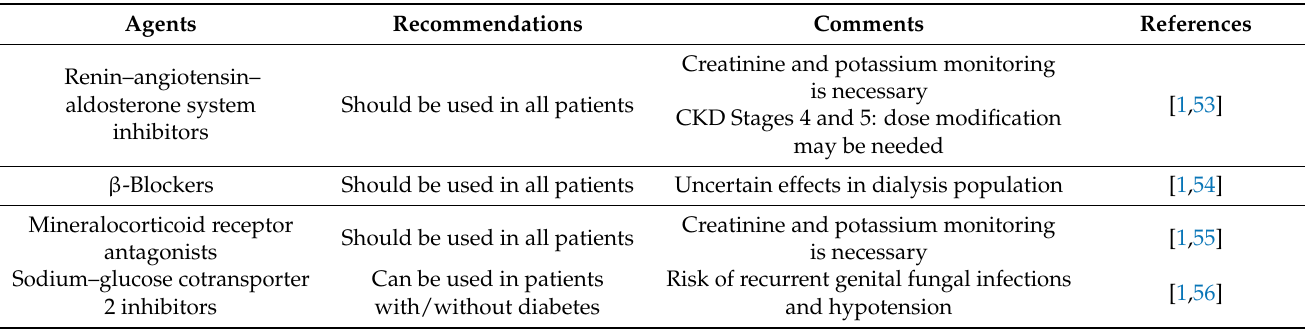
Table 1. Pharmacotherapy of HFrEF in patients with